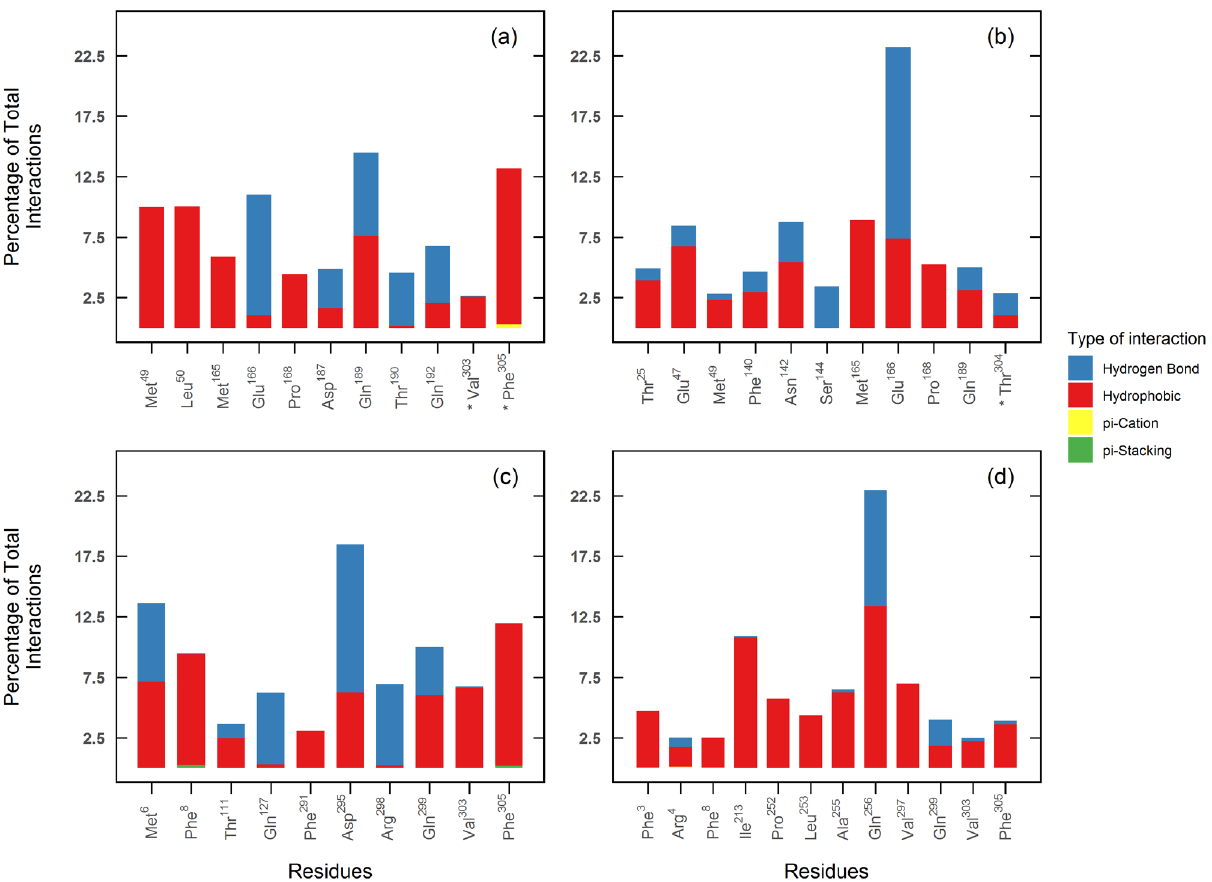
Figure 8. Interaction types for selected ligands as percentage of total interactions. Interaction types are limited to hydrogen bonds (blue), hydrophobic interactions (red), π-Cation contacts (yellow), and π-π stacking contacts (green). Residues with under 2.5% of interactions are not shown. Asterisks (*) indicate residues as belonging to protomer B, the default being protomer A. Note that not all ligands share the same number of interactions, so equal percentages do not mean equal number of interactions. SBS : ( a ) dorsilurin E, ( b ) euchrenone a11. DS : ( c ) sanggenol O. CS : ( d )